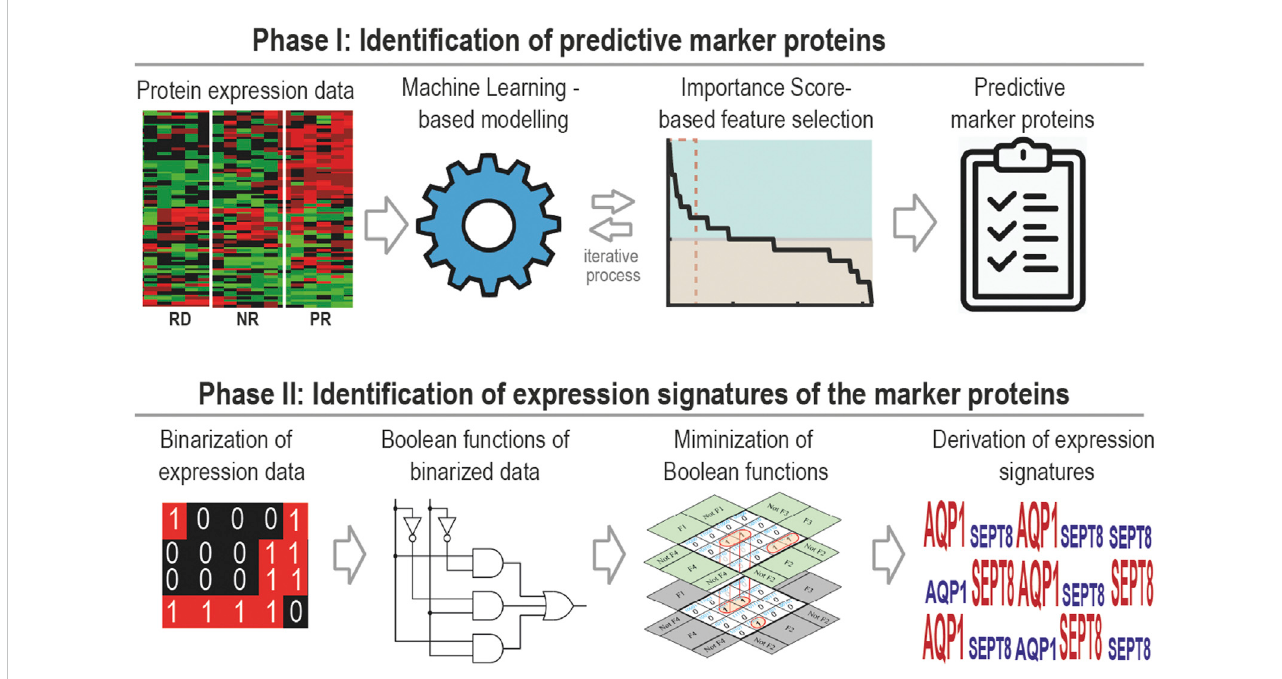
FIGURE 1 A general work fl ow of our two-phase computational framework, which couples supervised machine learning-based biomarker discovery with Boolean algebra-based signature derivation for the identi fi cation of predictive